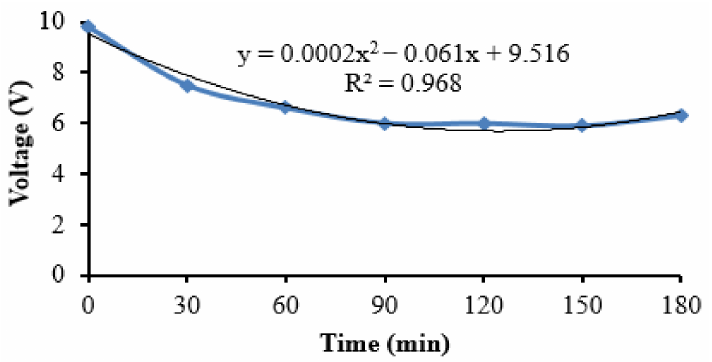
Figure 8. Change in voltage on the